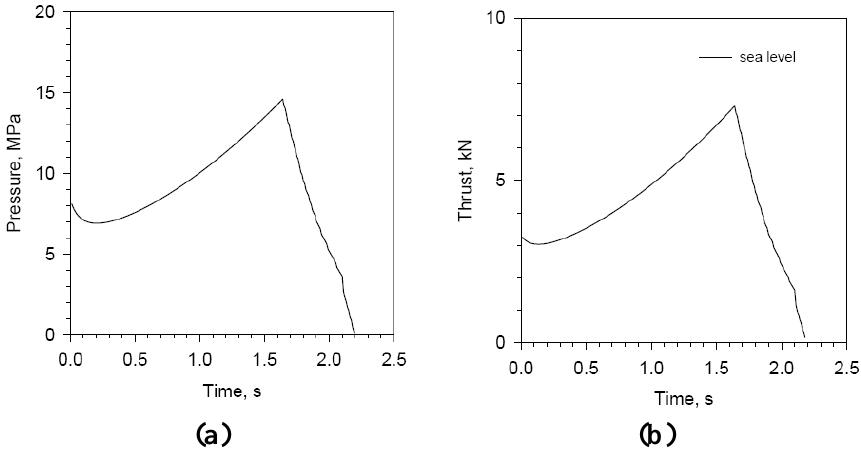
Figure 3. (a) Predicted head-end pressure profile for small cylindrical-grain SRM; (b) Corresponding predicted thrust